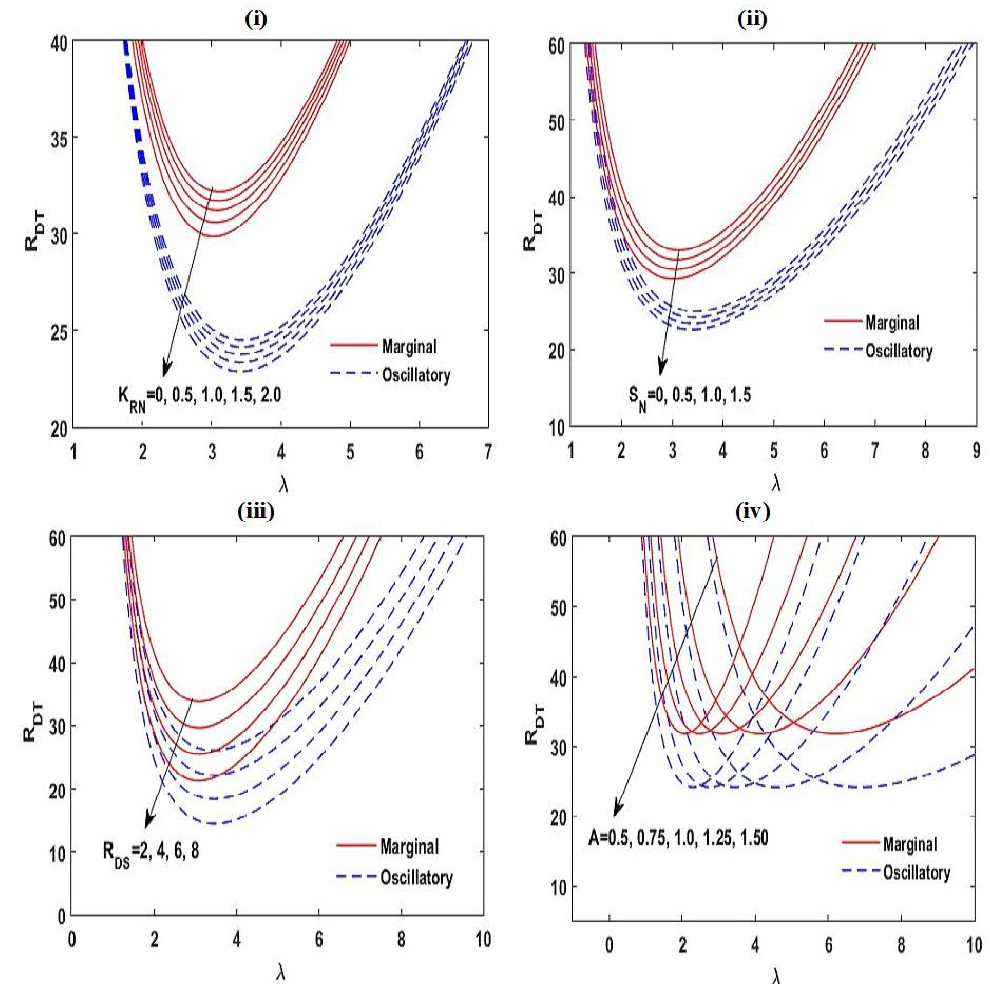
Figure 3. The effect of K RN , S N , R DS , and A on the neutral stability curves at Le = 2, γ = 0.5, m = 1.5, A = 1, R DS = 3, S N = 0.5, K RN = 0.5, and Va = 3 with variation in one of these parameters.